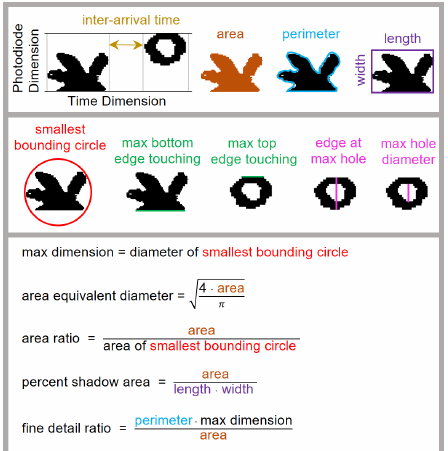
Figure A1. Schematic showing how to compute particle features from 2D-S particle images. Particle features are listed in Table 1. Under- scores are left out of the feature names. touching_edge is not shown here because it is a binary variable.